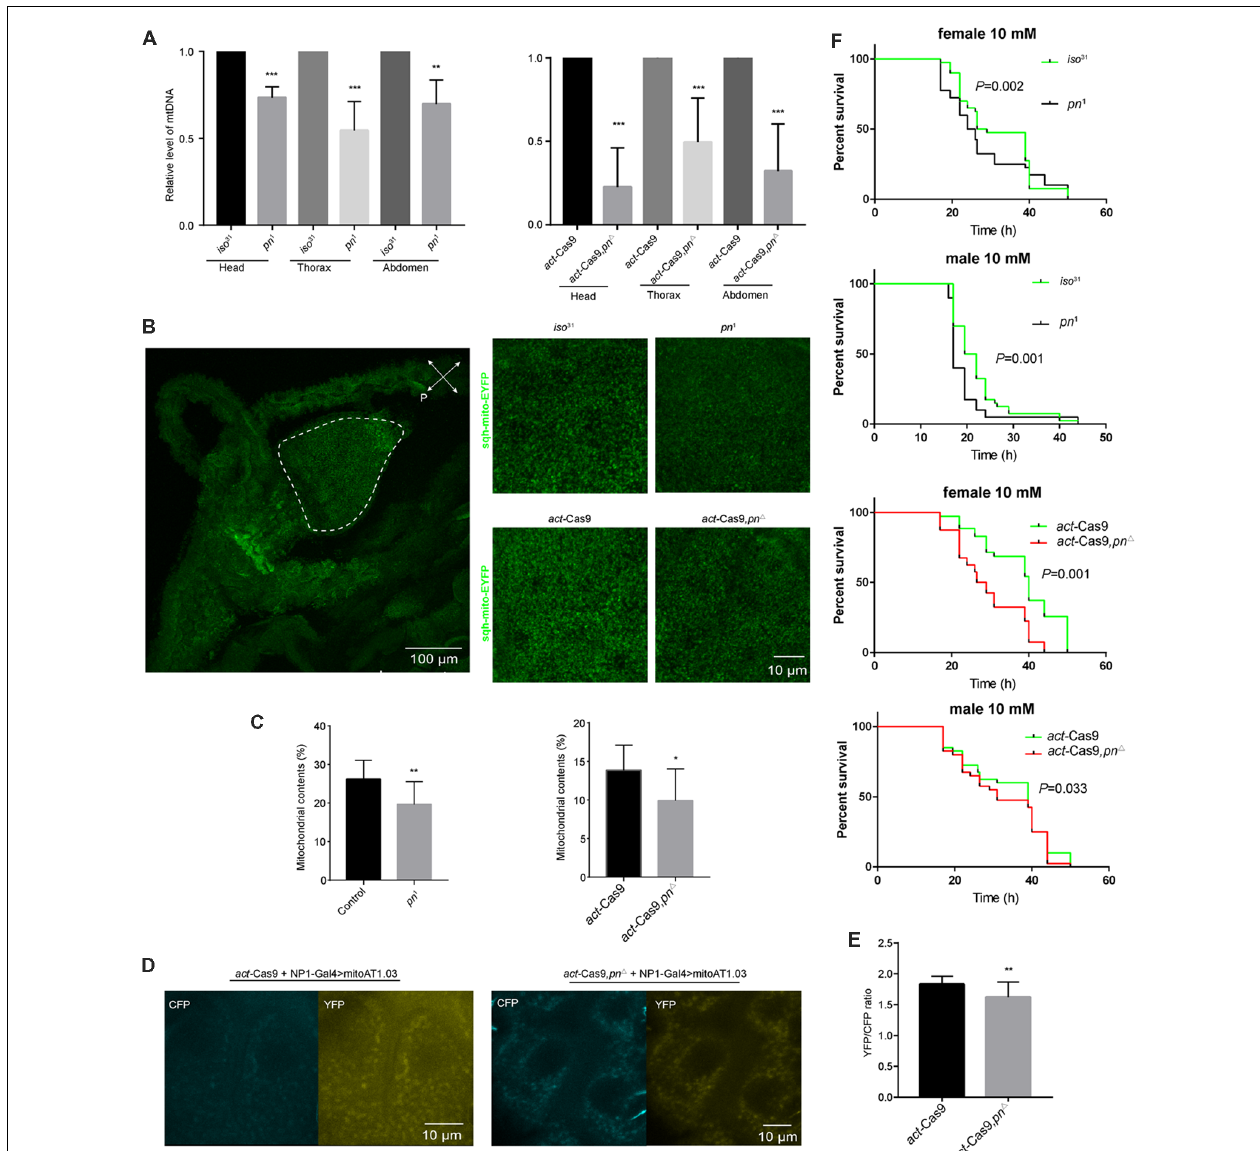
FIGURE 4 | Loss of pn causes mitochondrial dysfunction. (A) Analysis of mitochondrial DNA (mtDNA) in head, thorax, and abdomen of pn 1 , pn (cid:52) mutant and control flies. (B) Left: image of representative proventriculus cell from the foregut of the 3rd larval of a control fly that expresses mitochondrial label sqh -mitoEYFP. Right: representative images of higher magnification proventriculus cells from pn 1 , pn (cid:52) mutant and control flies labeled with sqh -mitoEYFP. (C) Comparison of the mitochondrial contents in pn 1 , pn (cid:52) mutant and control flies. Means ± SD are shown ( n = 10). ∗ P < 0.05, ∗∗ P < 0.01, ∗∗∗ P < 0.001. (D) Image of representative midgut cells from the 3rd larval of control and pn (cid:52) mutant flies labeled with mitoAT1.03 under the driver of NP1-Gal4. (E) Comparison of YFP/CFP ratio of mitoAT1.03 in control and pn (cid:52) mutant flies. Means ± SD are shown ( n = 8). ∗∗ P < 0.01. (F) Pn mutant and control flies were treated with 10 mM paraquat and were tested for survival curve. Percent survival and times are indicated on the y and x axes, respectively. Two independent repeats were performed. P value are shown on the figures ( n =